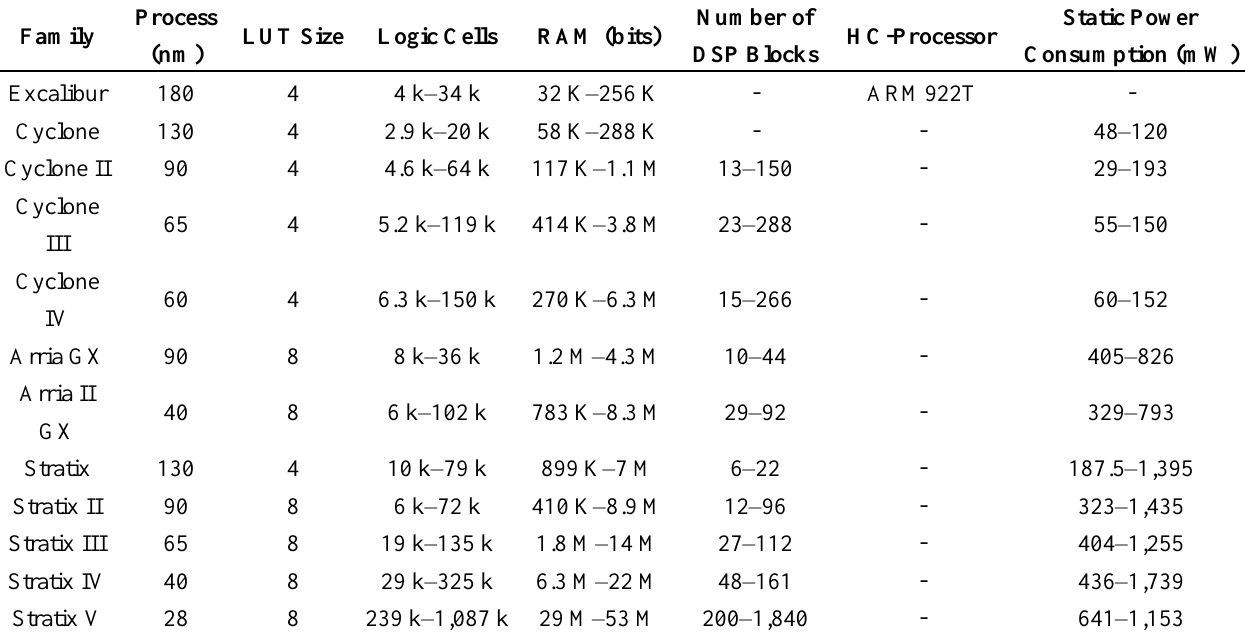
Table 2. Characteristics and static power consumption of the different FPGA series of